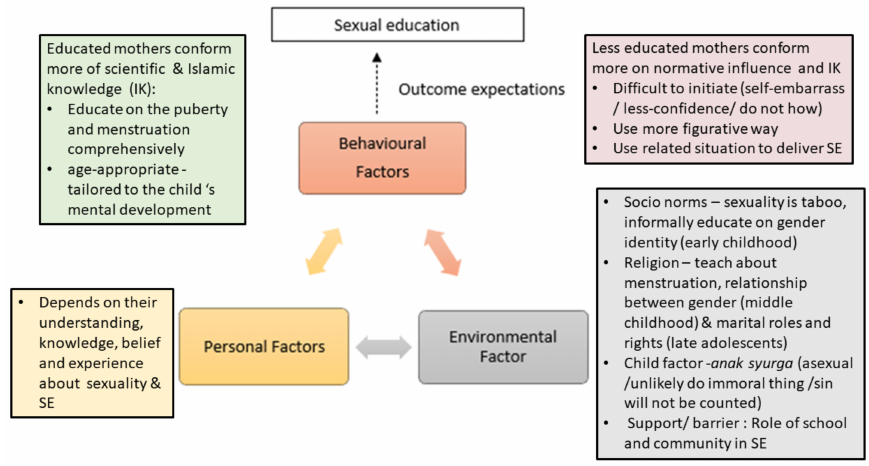
Figure 2. Effect of personal factors, sociocultural norms, and behavior factors on mothers’ choices regarding sexual education